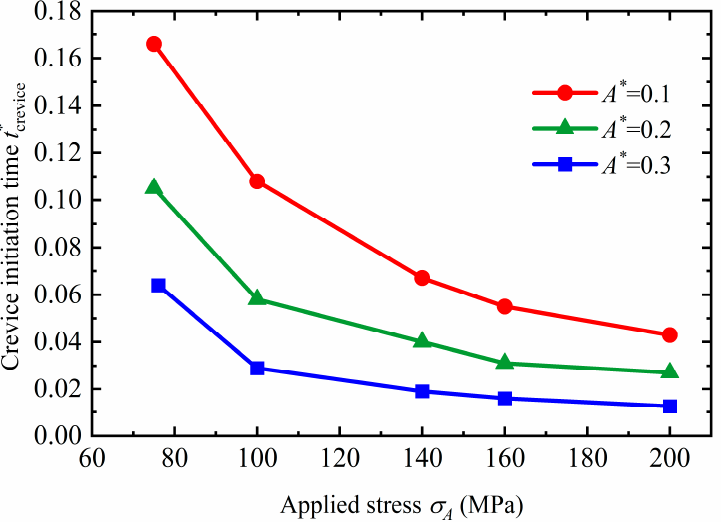
Figure 10. Crevice initiation time * crevice t for different A σ and * A .